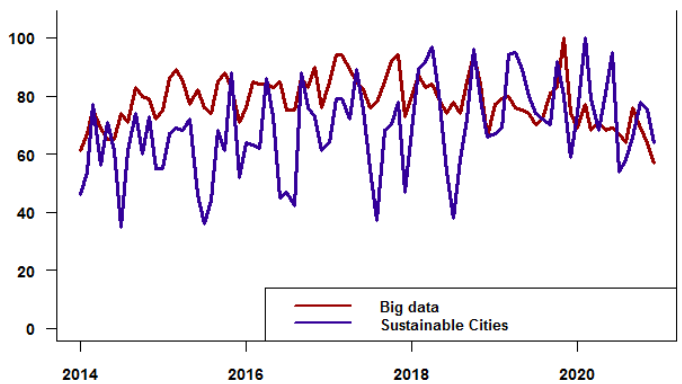
Figure 12. Big Data and SDG 11 global Google trends since